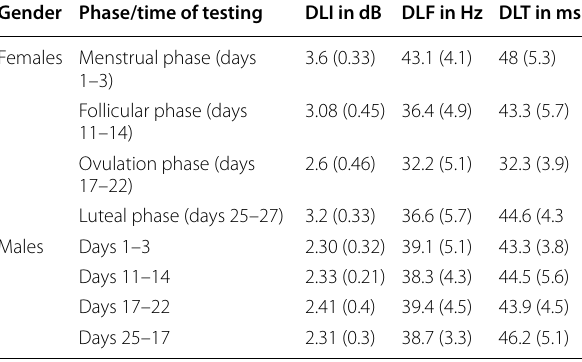
Table 1 Mean and standard deviation (in parenthesis) of scores obtained for all the three tests in males and females at different